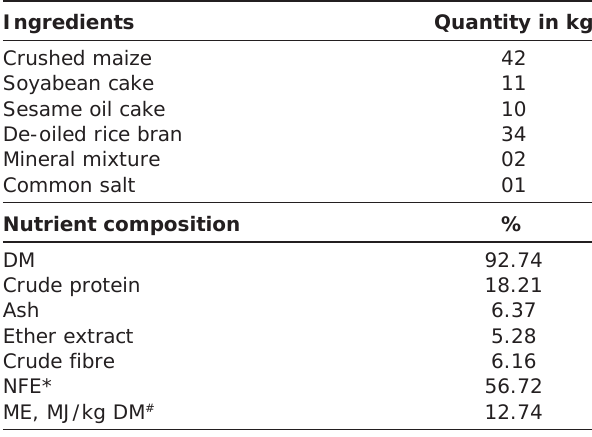
Table-1: Ingredients and nutrient composition (%) of the concentrate mixture.